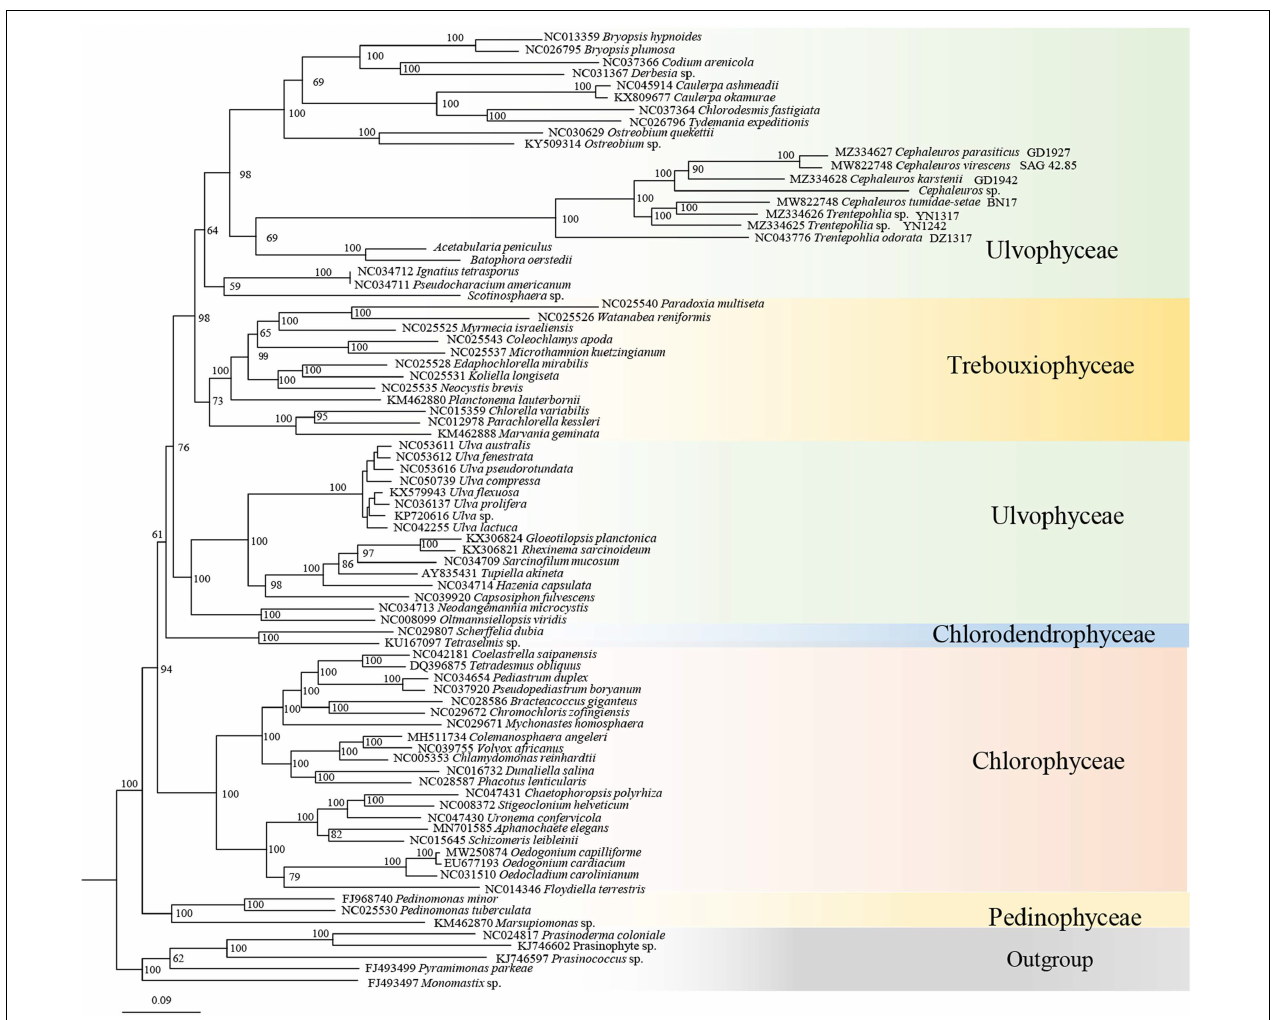
FIGURE 8 | ML phylogenetic tree inferred from nucleotide dataset partitioned by gene position. Maximum likelihood bootstrap values (1000 replicates) are given near the nodes. Scale bar indicates substitutions per